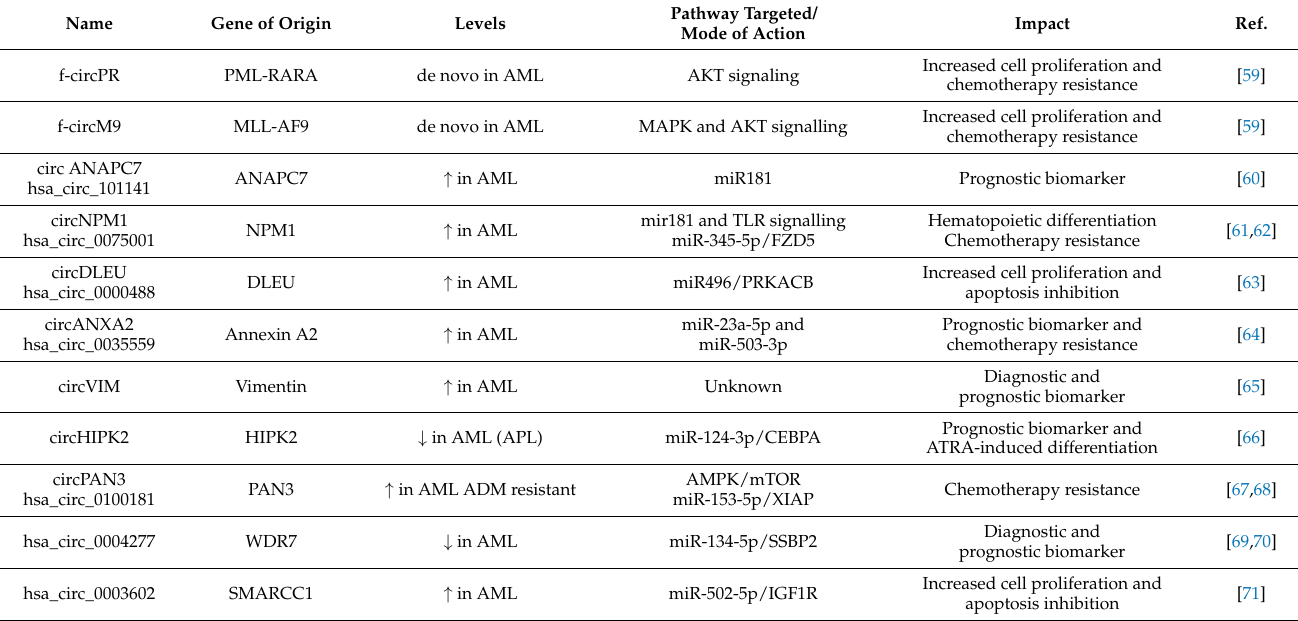
Table 1. Updated list of circRNAs involved in AML onset, progression and therapy resistance. Arrows ↑ and ↓ stand for upregulation and downregulation